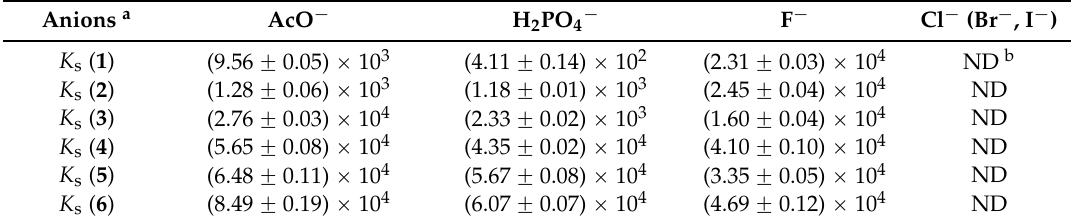
Table 1. Binding constants of compounds with various anions.